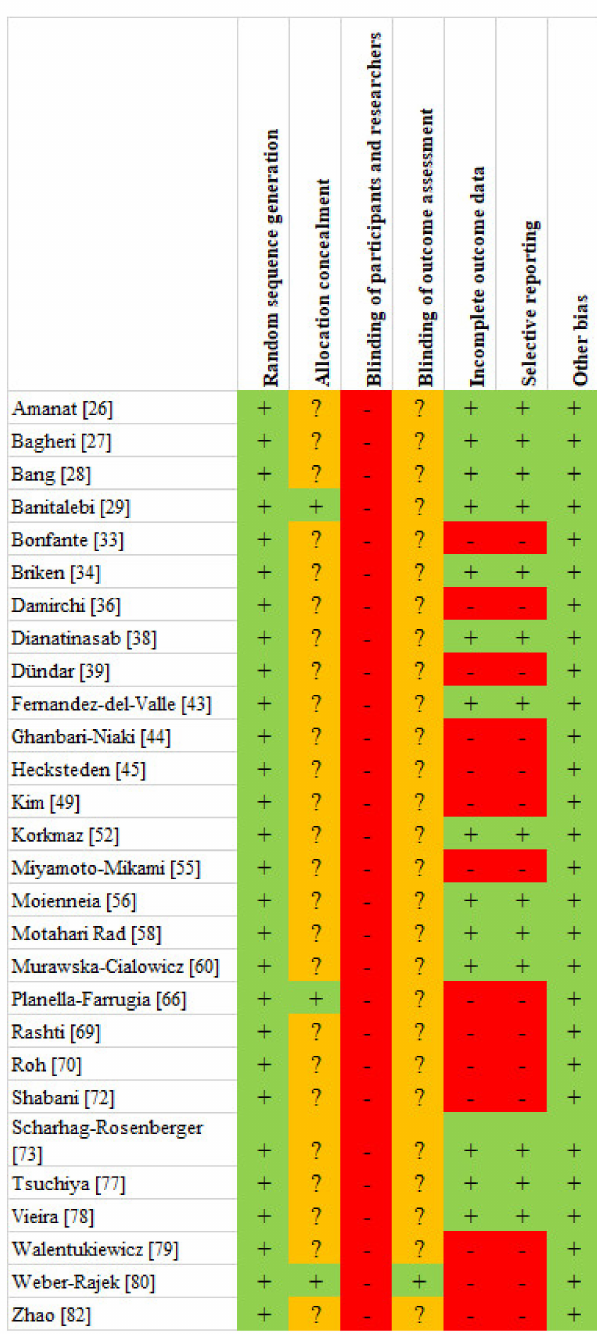
Figure 2. Risk of bias assessment using the RoB 2 for randomized control trials. Note : + Low risk; ? Some concerns; - High